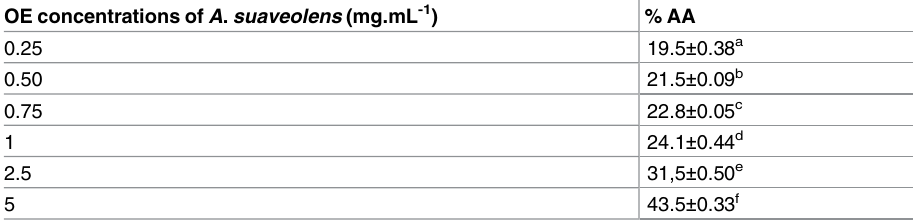
The values correspond to the mean and standard deviation of triplicates. Different letters indicate a significant difference (p < 0.05). Equation antioxidant activity Y = 4,96x +